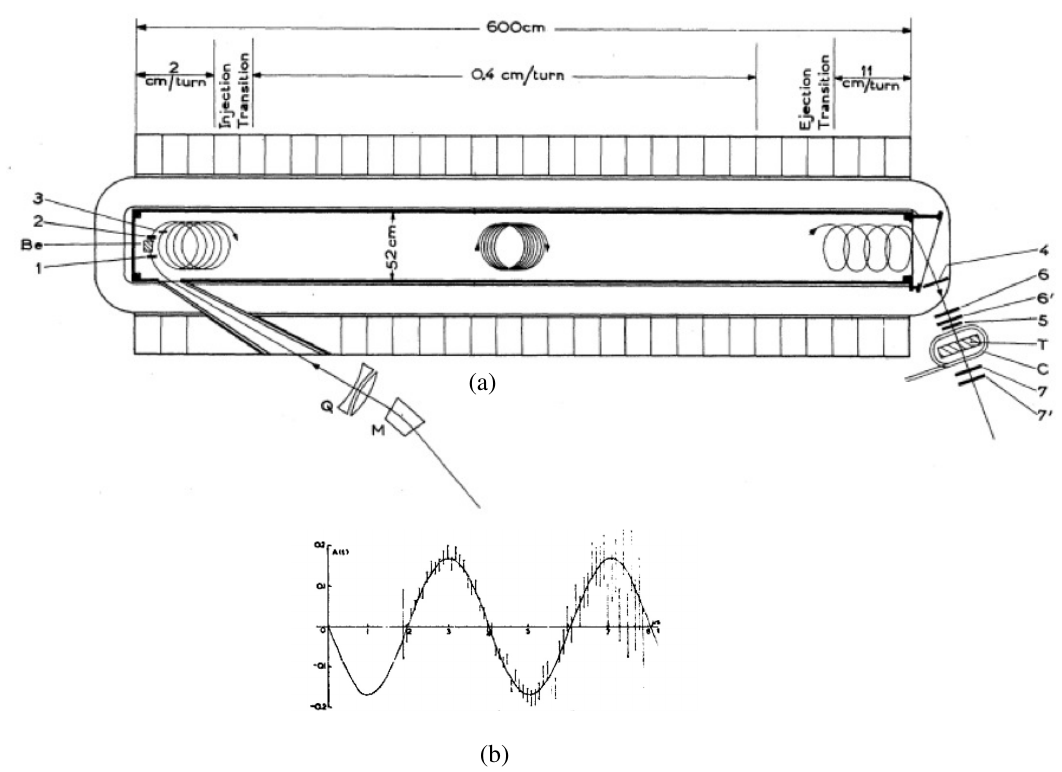
Figure 4: (a) The experimental set up for the first CERN ( g − 2 ) experiment [ 32 ] . An incident µ + beam from the CERN SC was injected into a long dipole magnet, with the incident muon defined as a coincidence of the counters 1,2 and 3. A beryllium